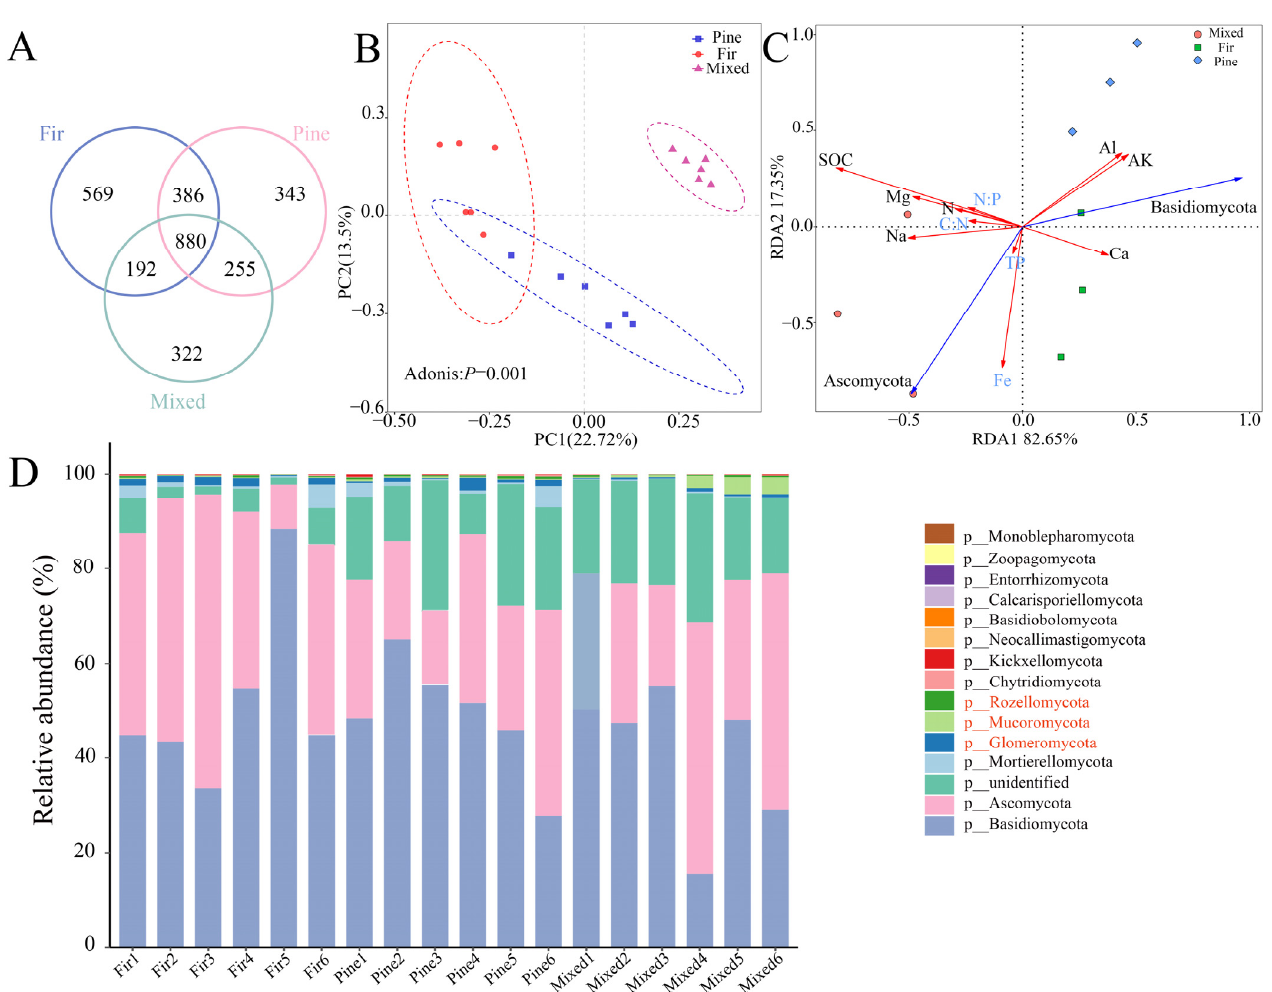
Figure 3. Diversity and composition of soil fungi in pure and mixed forest. ( A ) Venn diagram of fungal OTU numbers, ( B ) principal coordinate analysis (PCoA) ordination of soil fungi, ( C ) redun- dancy analysis (RDA) of the fungal community structure and soil chemical properties. The red and blue arrows indicate soil chemical properties and the two most abundant fungal phyla, respectively. Soil chemical properties depicted in blue exhibited a significant correlation with fungal communi- ties ( p < 0.05). ( D ) Variations in the taxonomic composition of fungal communities at the phylum level; red text represents significant differences at the 0.05 level. SOC: soil organic carbon; TN: total nitrogen; C:N: C:N ratio; N:P: N:P ratio; TP: total phosphorus; AK: available potassium.